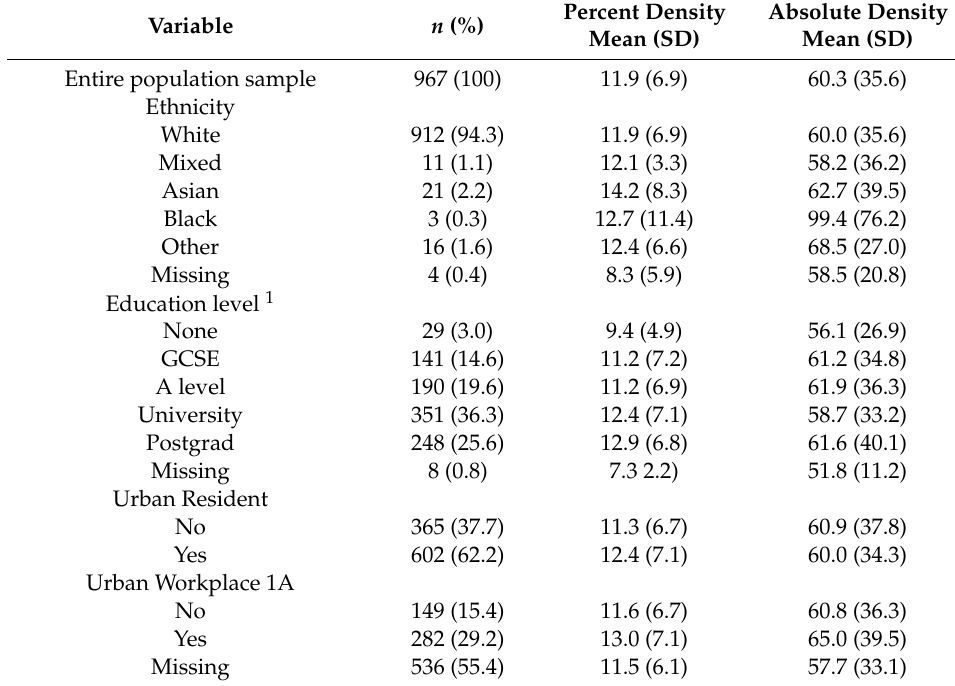
Table 1. Characteristics of the population sample ( n =